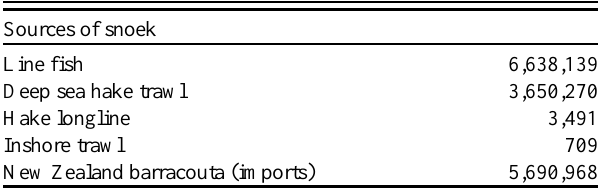
Table 1 . Thyrites atun , Snoek catch, landings, and imports from New Zealand